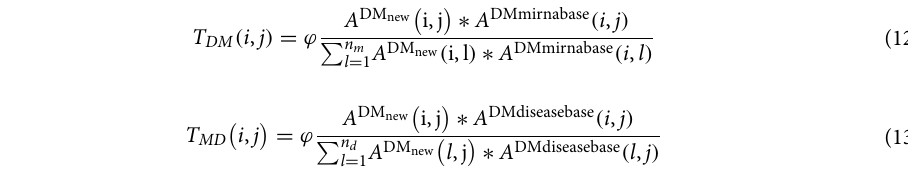
probability from disease d i to disease d j as in Eq.